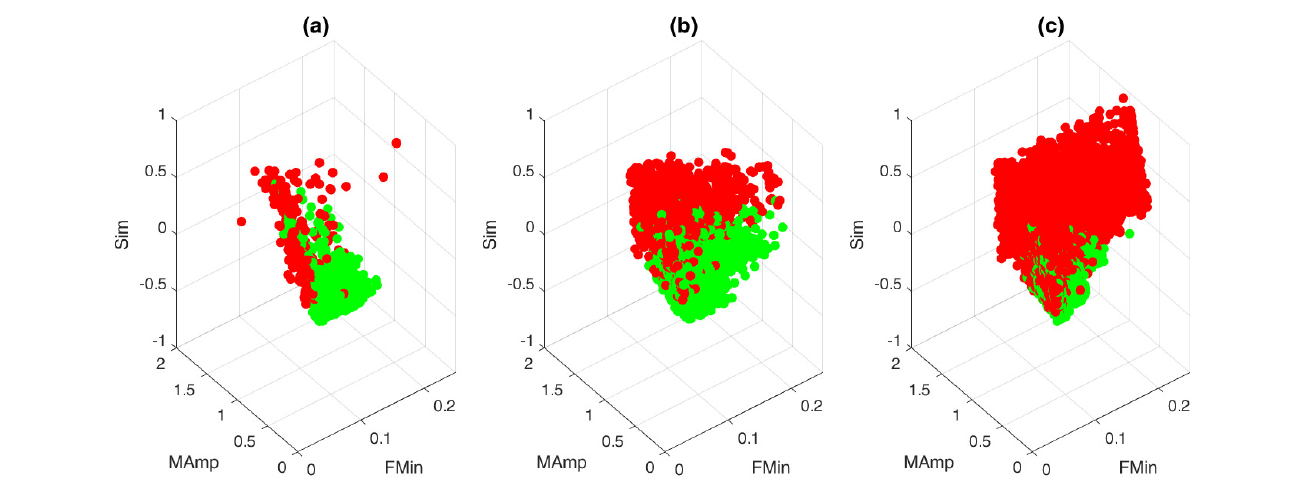
Figure 5. Feature space of the three datasets. Green dots indicate clean samples, red dots indicate noisy samples: ( a ) PSG dataset. ( b ) HH dataset. ( c ) CC